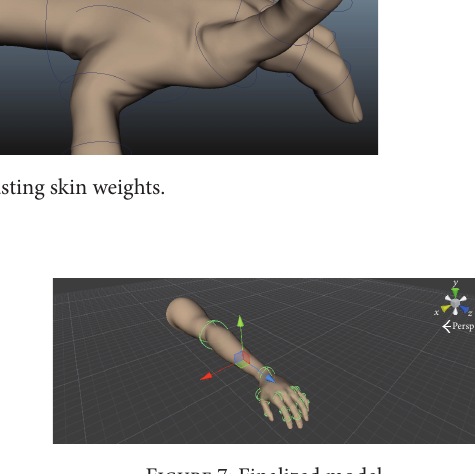
Figure 6: Figure within interface. Figure 7: Finalized